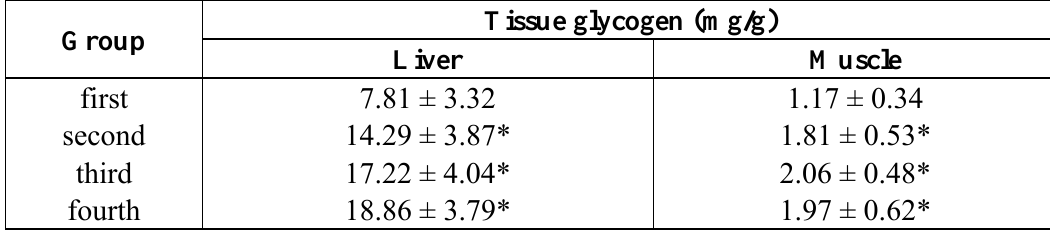
Table 1. Effect of ASSE on tissue glycogen of mice. Values represent the means ± SE (n = 10 per group). * P < 0.05 when compared to control